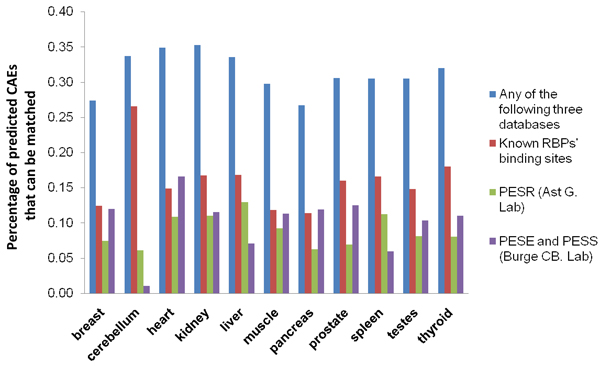
Matching results from predicted CAEs to known RBPs' binding sites and predicted exonic splicing regulator databases. The percentages of predicted cis-acting RNA elements (CAEs) matching to known RBPs' binding sites, predicted exonic splicing regulators (PESR by Ast G. Lab), predicted exonic splicing enhancers and silencers (PESE and PESS by Burge CB. Lab) and any of above three databases are represented as barplots with different colors.